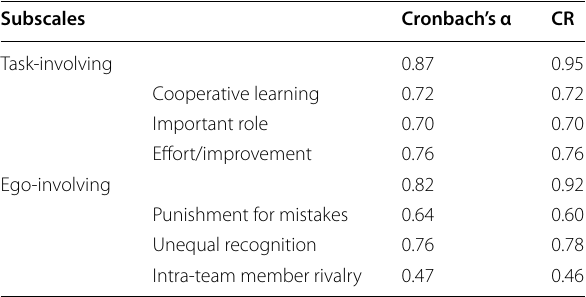
Table 5 Internal consistency estimation of PMCSQ-2BR and its scales